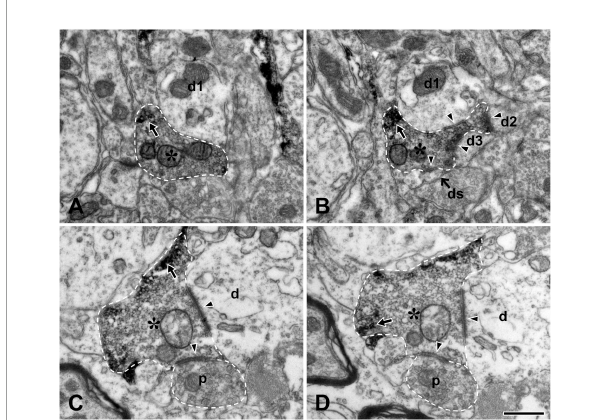
FIGURE3 Electron micrographs of adjacent thin sections ( A and B , C and D , each pair about 200 nm apart) in the trigeminal caudal nucleus (Vc). (A,B) A TRPV1+ bouton (asterisk) makes a synaptic contact with 3 dendritic shafts (d1–d3) and one dendritic spine (ds). (C,D) A TRPV1+ bouton (asterisk) makes a synaptic contact with one dendritic shaft (d) and receives an axoaxonic synapse from a presynaptic ending containing pleomorphic vesicles (p). Arrows indicate electron dense TRPV1 immunoreaction product. Arrowheads indicate synapses. TRPV1+ boutons and presynaptic ending are outlined with a dashed line. Scale bar = 500 nm in panel (D) (also applies to panels A–C